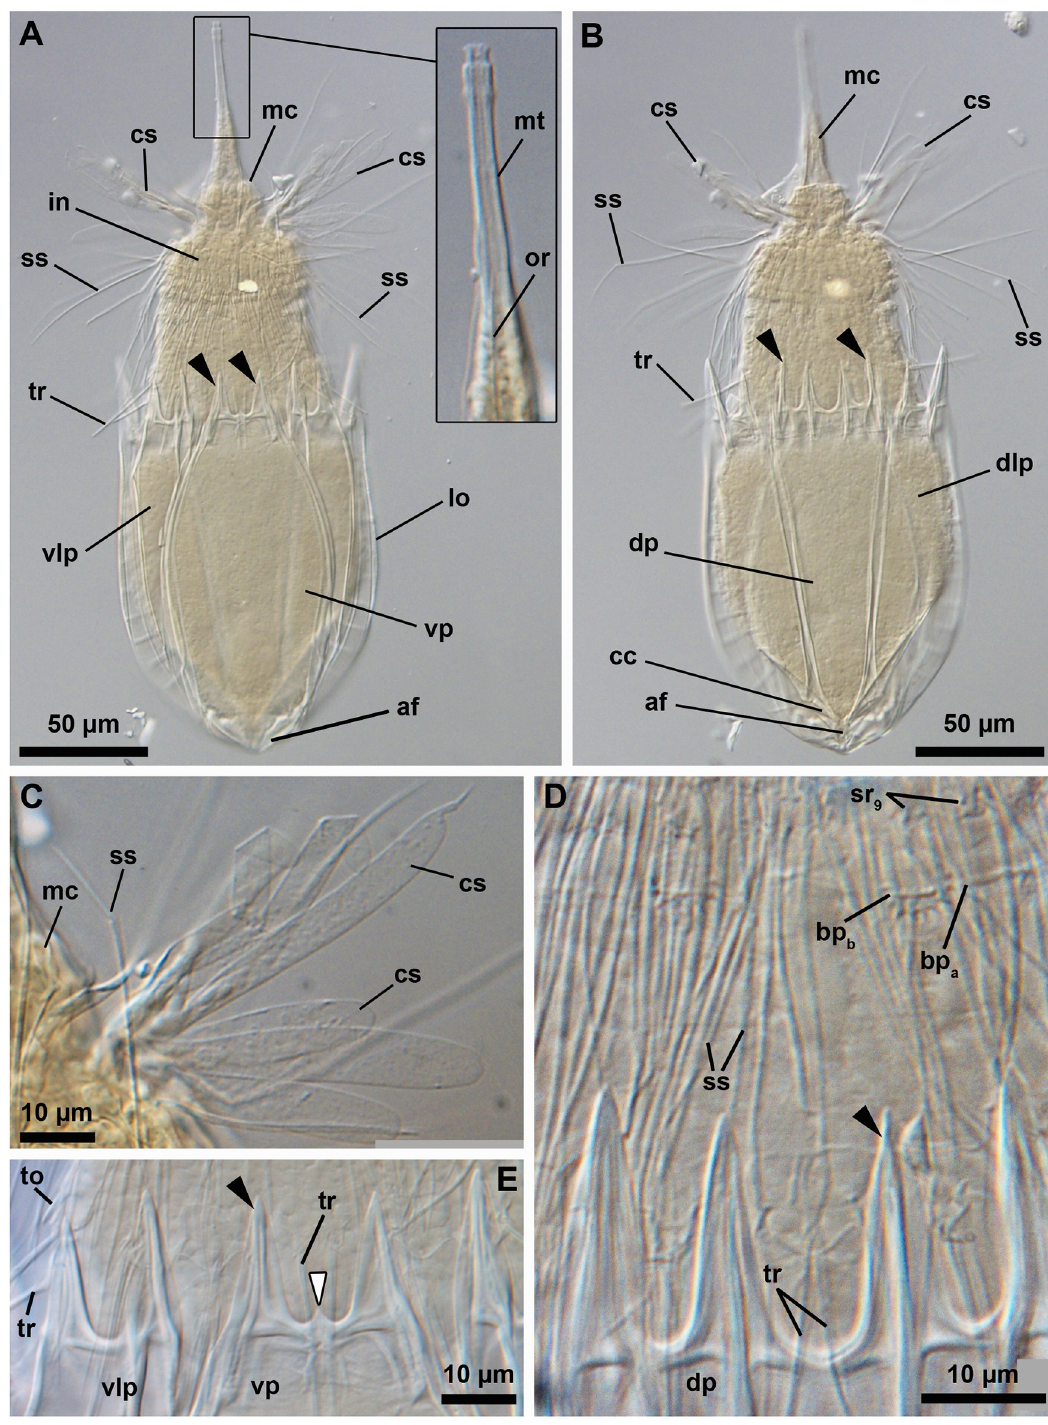
Fig 9. Light micrographs of the holotypic adult male of Nanaloricus mathildeae sp. nov. Anterior faces up in all aspects. (A) Ventral view of the extended specimen. Black arrowheads indicate anterior spikes. The inset shows a detail of the mouth tube (mt), which is not fully extended. (B) Dorsal view of the specimen. (C) Close-up of multiform clavoscalids (cs). (D) Close-up of the introvert and anterior spikes of the dorsal plate. Note the presence of basal plates of type a and b (bp a/b ), and spinoscalids of 9 th row (sr 9 ); (E) Close-up of the anterior spikes of the ventral and ventrolateral plates. White arrowhead points to the small midventral anterior spike. Abbreviations: af, anal field; cc, cuticularized crest; cs, clavoscalid; dlp, dorsolateral plate; dp, dorsal plate; in, introvert; lo, lorica; mc, mouth cone; mt, mouth tube; or, oral ridge; ss spinoscalid; to, trichoscalid sensory organ; tr, trichoscalid; vlp, ventrolateral plate; vp, ventral plate.